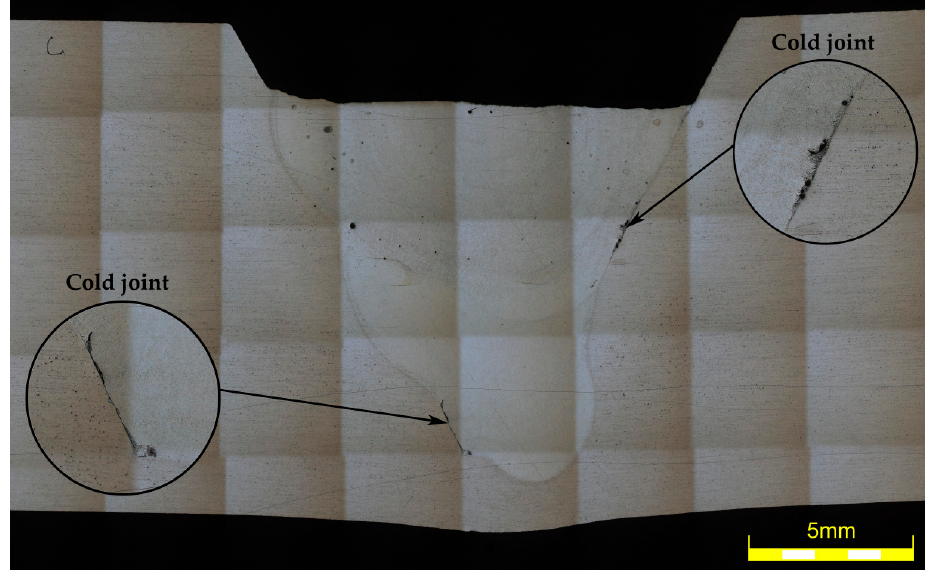
Figure 4. Metallographic scratch pattern of the joint after welding and without preheating.